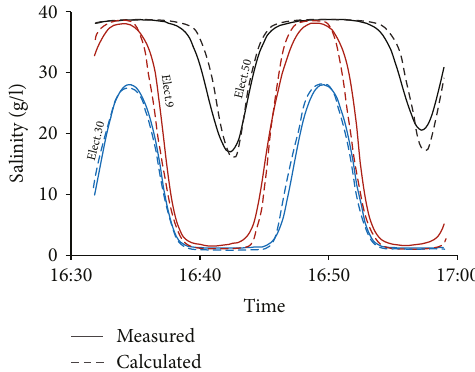
Figure 8: Comparison between observed (solid) and calculated (dashed) salinities at three electrodes whose locations are shown in Figure 1(b).